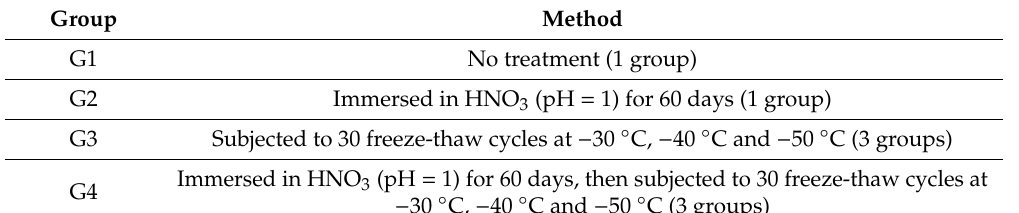
Table 2. Groups of specimens treated by different methods.